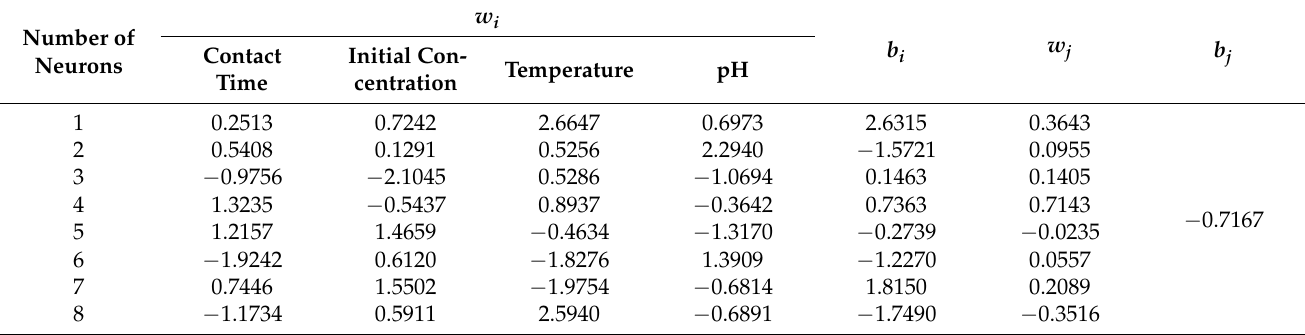
Table 10. The weights and biases of BP-ANN in input-hidden layer ( w i and b i ) and hidden-output layer ( w j and b j